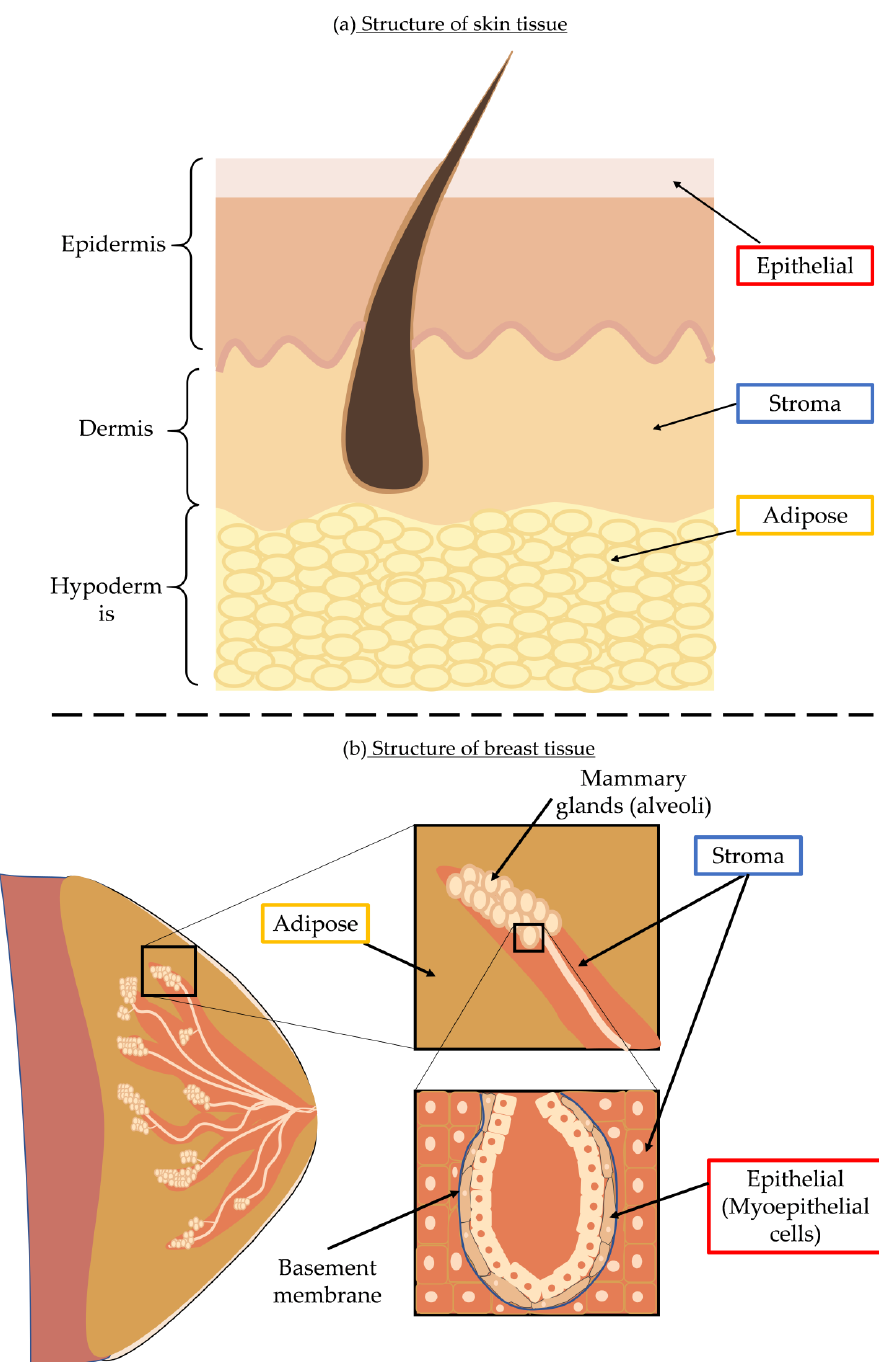
1 Figure 3. Tissue composition of skin and breast. ( a ) The skin is composed of an outer epidermis (containing epithelial cells), the dermis (containing stromal cells) and the subcutaneous layer (hy- podermis) containing adipocytes. ( b ) Breast tissue contains epithelial cells that make up the alveoli structures, adipose tissue, as well as connective tissues or stroma. This structural composition is akin to skin, albeit with different spatial distribution but serves comparable purposes and could be similarly affected by radiation